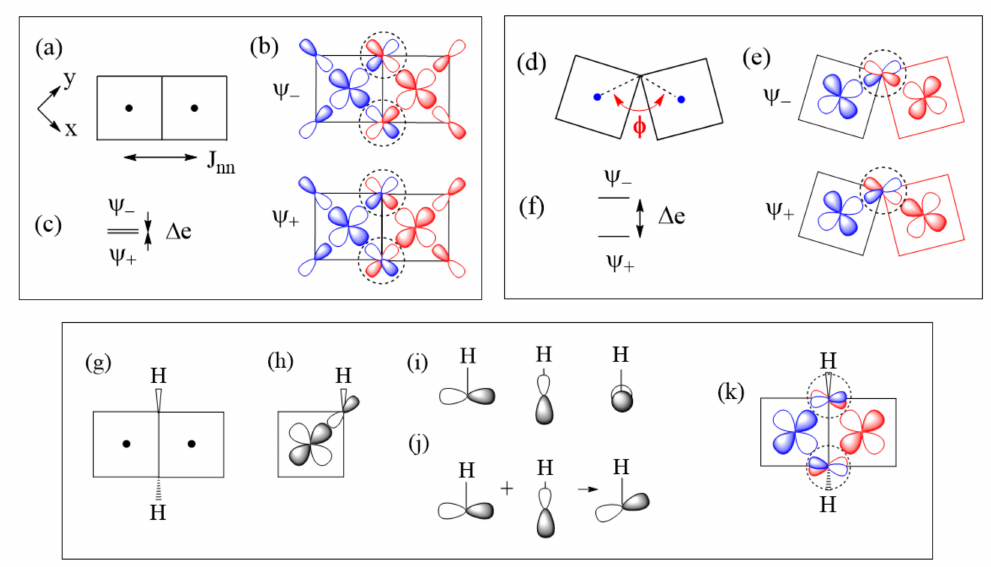
Figure 10. ( a – c ) A Cu–L–Cu spin exchange with ∠ M–L–M angle φ = 90 ◦ : This occurs in a Cu 2 L 6 dimer shown in ( a ), which is made up of two coplanar CuL 4 square planes by sharing an edge. The in-phase and out-of-phase combinations of the two magnetic orbitals in ( b ), and the energy split ∆ e between the two in ( c ). ( d – f ) A Cu–L–Cu spin exchange with ∠ M–L–M angle φ > 90 ◦ : This occurs when two non-coplanar CuL 4 square planes are corner-shared as in ( d ). The in-phase and out-of-phase combinations of the two magnetic orbitals in ( e ), and the energy split ∆ e between the two in ( f ). ( g – k ) Effect of the molecular anions OH − on the spin exchange of the edge-sharing Cu 2 O 6 dimer: the shared edge consists of two OH − ions in ( g ); the p-orbital tail of one OH − ligand in a CuO 4 square plane expected if the OH − is treated as O 2 − in ( h ); the three oxygen lone pairs associated with an isolated OH − in ( i ); the tilting of the O 2p-orbital tail by mixing two oxygen lone pairs in ( j ); and the arrangement of the tilted O 2p-tails at the bridging O atoms of the Cu 2 O 6 dimer in ( k